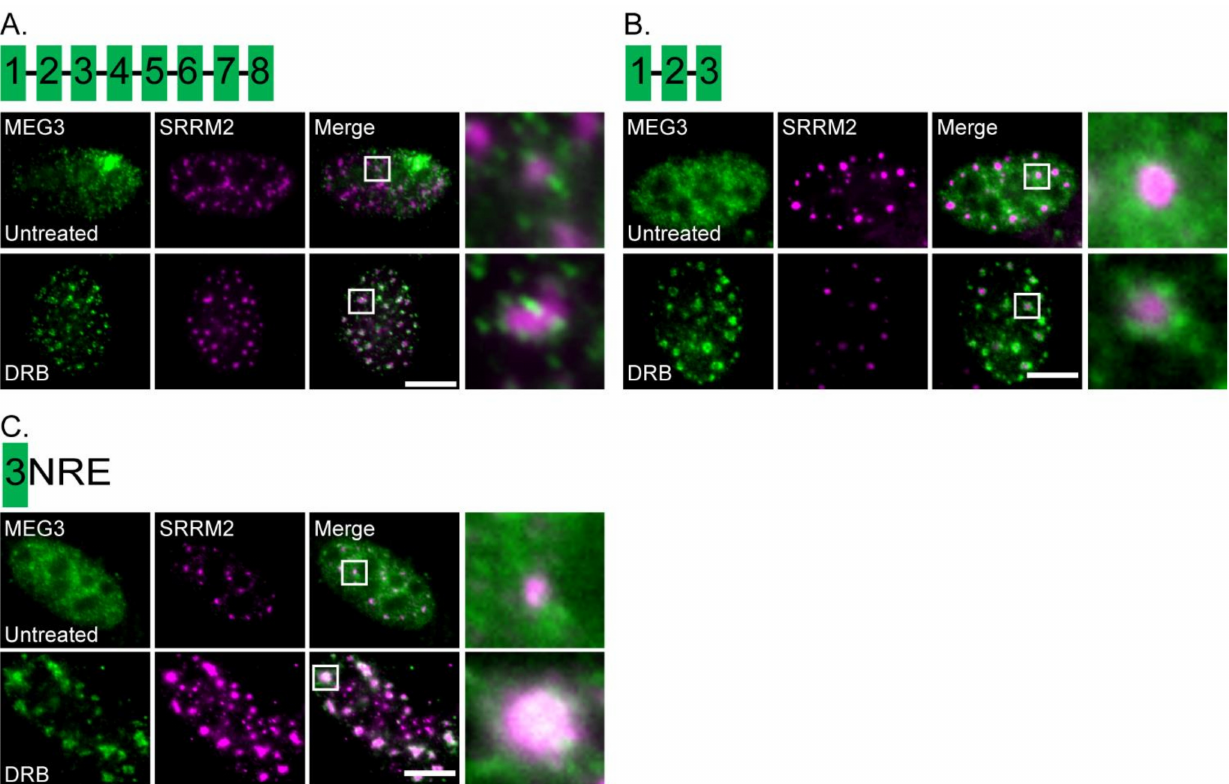
Figure 6. Part of exon 3 is required for MEG3 localization around nuclear speckles during transcrip- tion inhibition. ( A ) RNA FISH of full-length MEG3-MS2, ( B ) truncated transcripts (exons 1-3; green), and ( C ) 138 nts of the NRE in exon 3 were expressed in U2OS cells with SRRM2 staining (magenta). The localization of the transcripts was examined in untreated control cells (top) and cells treated with DRB (2 h, bottom). Depictions of the MEG3 exons (green boxes) in each construct are shown above the images. Enlargements of the boxed areas are on the right. Bars = 10 µ